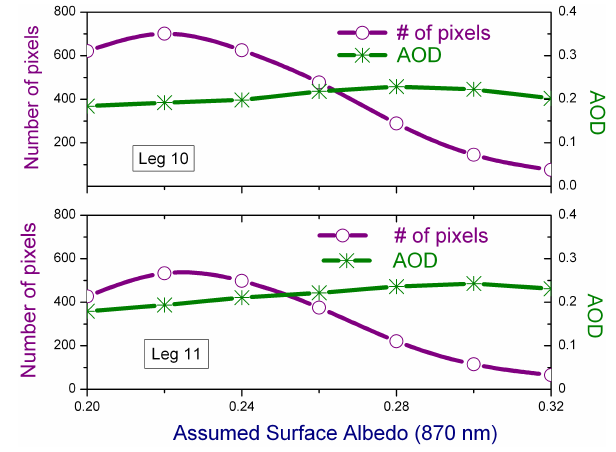
Fig. 6. Example of the RR-based AOD retrieval: population of clear pixels with the retrieved AOD and the domain-averaged AOD (660nm) as function of assumed surface albedo (870nm) for leg 10 (top) and leg 11